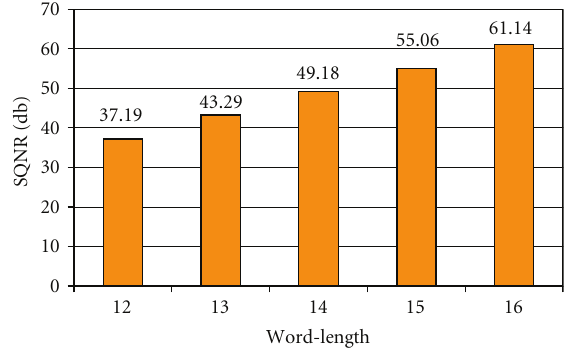
controller and compatibility with pipelining insertion.